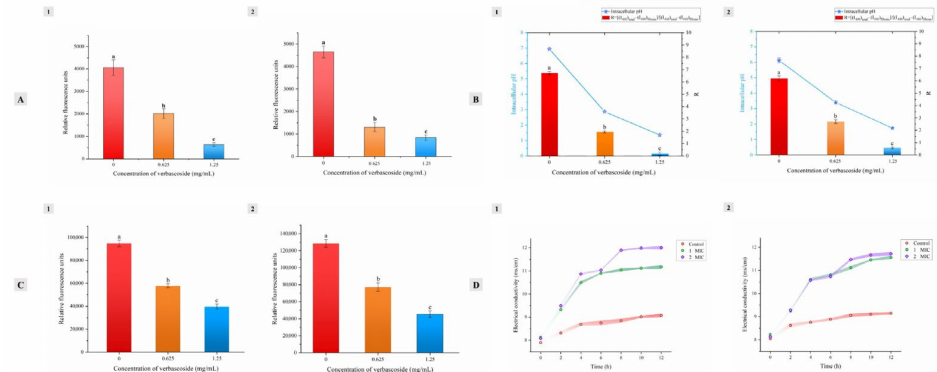
Figure 3. Effects of various concentrations of verbascoside on membrane permeability. ( A ) Intra- cellular ATP. ( B ) Intracellular pH. ( C ) Membrane potential. (D ) Electrical conductivity. (1) MDR Staphylococcus aureus SA-596; (2) MDR Pseudomonas aeruginosa PA-69. The values are expressed as the mean ± standard deviation (n = 3). a–c Values with different lowercase letters are significantly different at p <